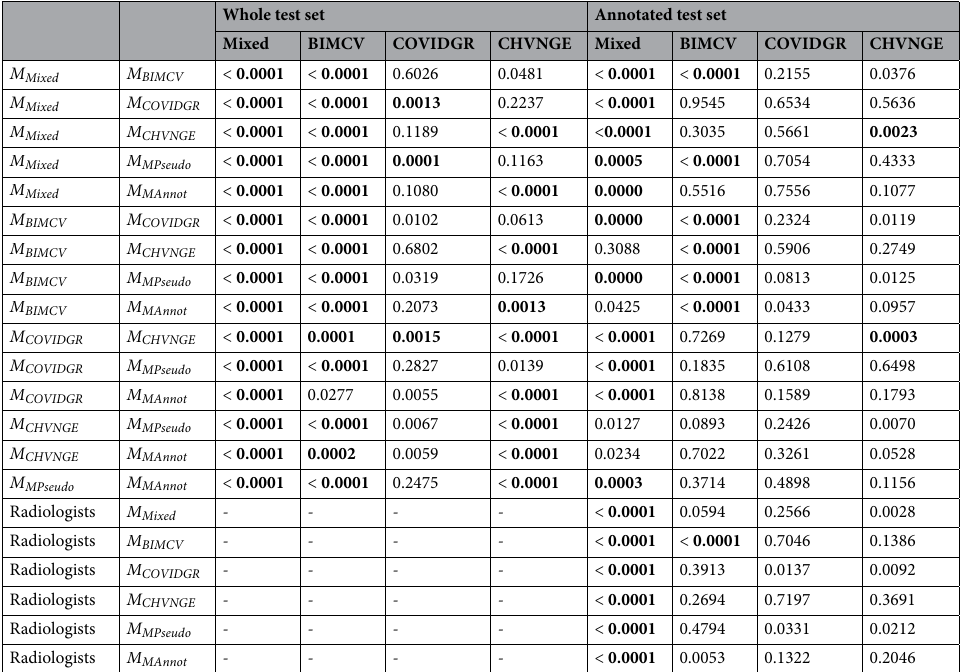
Table 6. Statistical significance of differences in AUC between readers (models and radiologists) for each dataset according to the De Long test. Bold indicates statistical significance with Bonferroni correction ( p < 0.0033 and p < 0.0024 for the test set and annotated test sets